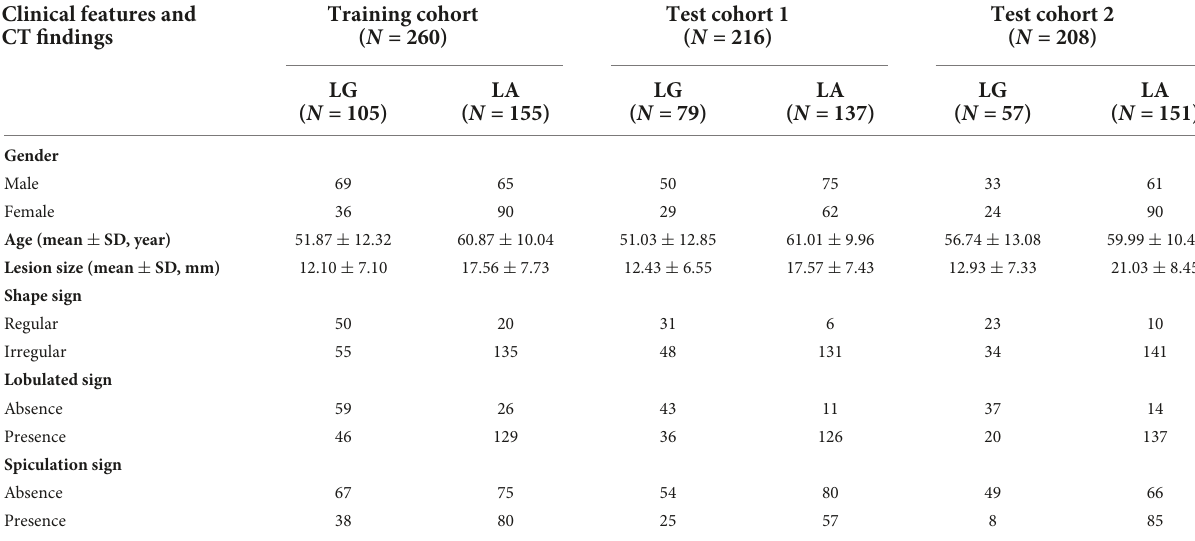
TABLE 1 Information of SPSN patients in this study. Clinical features and CT